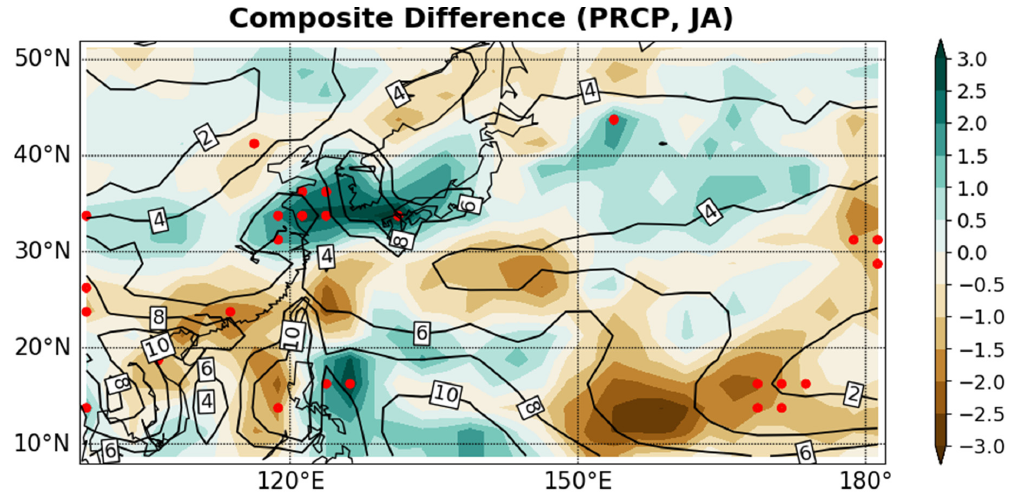
Figure 3. The difference (high AOD minus low AOD) of composited precipitation from the Global Precipitation Climatology Project (GPCP) between the high AOD and the low AOD in July–August (JA). Regions with a red dot indicate a statistical significance at a 95% confidence level. The unit is mm/day.